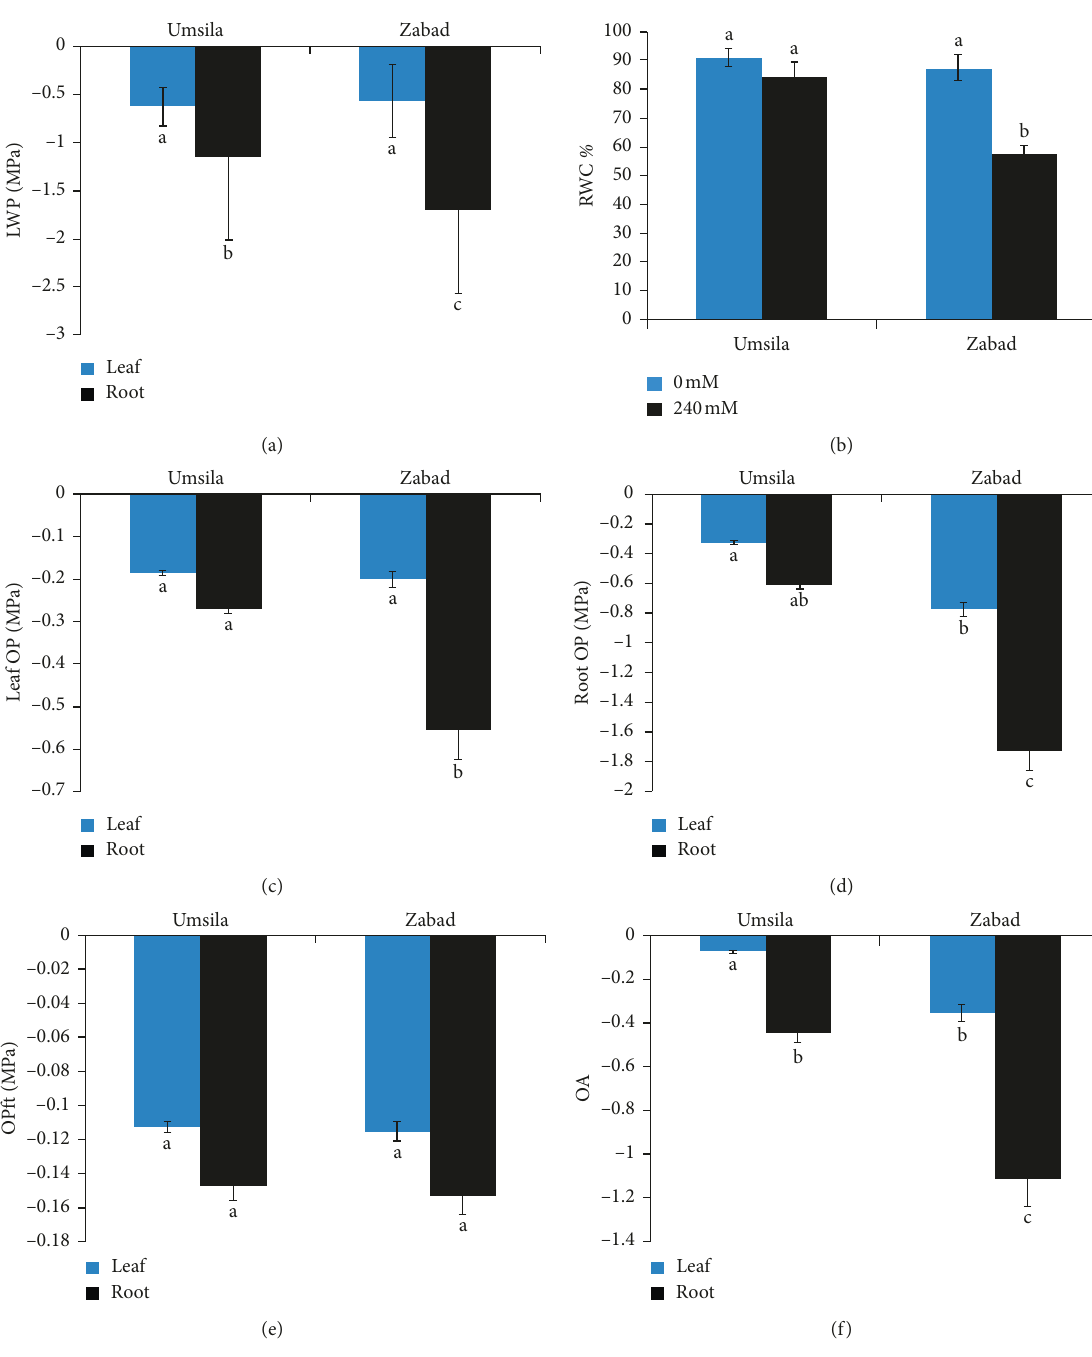
Figure 4: Leaf water potential (LWP) (a), relative water content (RWC) (b), leaf osmotic potential (leaf OP) (c), root osmotic potential (root OP) (d), osmotic potential at full turgor (OPft) (e), and osmotic adjustment (OA) (f) measured in Umsila and Zabad date palm cultivars when grown under control and salinity conditions. Bars represent mean ± SE ( n � 3). Statistical differences between the treatments were calculated based on p ≤ 0 .